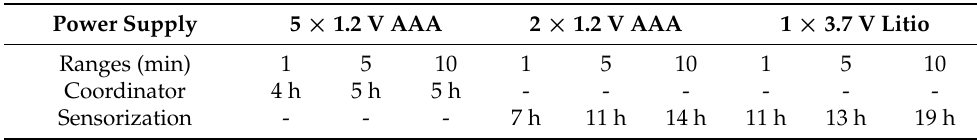
Table 3. Results obtained in the autonomy test. Power Supply Ranges